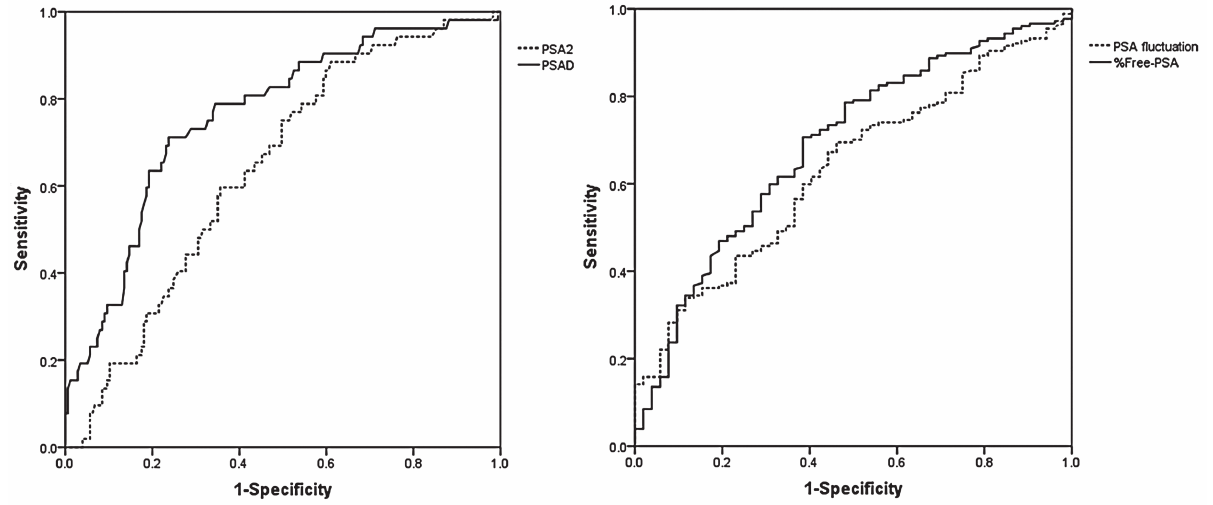
Figure 1 - Receiver operator characteristic curves analyses of secondary prostate-specific antigen (PSA antigen density (PSAD), percentage of free prostate-specific antigen (%Free-PSA), and prostate-specific antigen (PSA) fluctuation. The optimal cut-off values for detecting prostate cancer were defined as 4.92 ng/mL in PSA specificity, 56.5%; area under curve (AUC), 0.64; P=0.002), 0.155 ng/mL/g in PSAD (sensitivity, 73.1%; specificity, 71.2%; AUC, 0.762; P<0.001), 17.31% in %Free-PSA (sensitivity, 63.3%; specificity, 63.5%; AUC, 0.688; P<0.001), and 8.48 %/ month in PSA fluctuation (sensitivity, 61.6%; specificity, 59.6%; AUC, 0.633; P=0.004),